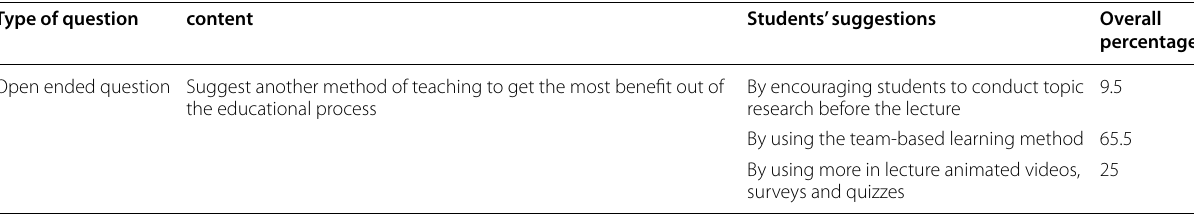
Table 2 Students’ suggestions for more engaging lecture Type of